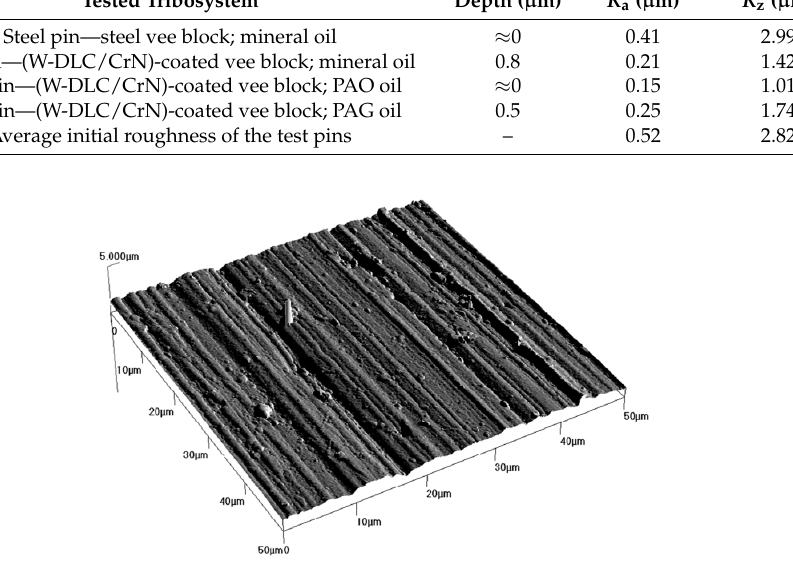
Figure 6. AFM image of the surface of the W ‐ DLC/CrN coating.